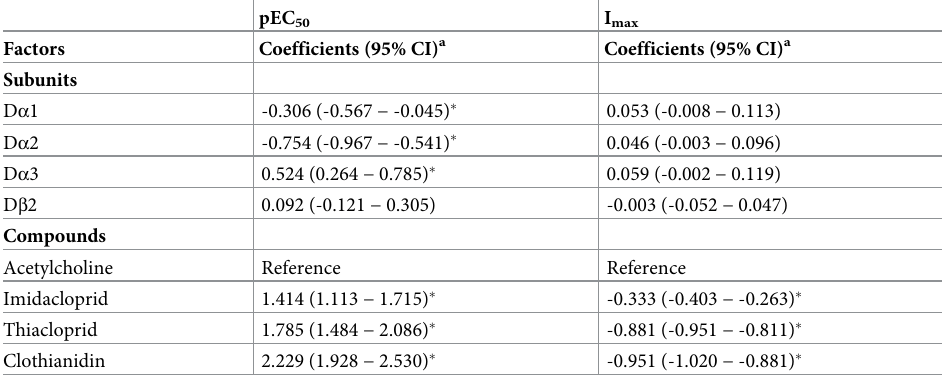
Table 2. Multivariate analysis of factors determining the affinity (pEC 50 ) and efficacy (I max ) of neonicotinoids. pEC 50 I max Factors Coefficients (95% CI) a Coefficients (95% CI) a Subunits